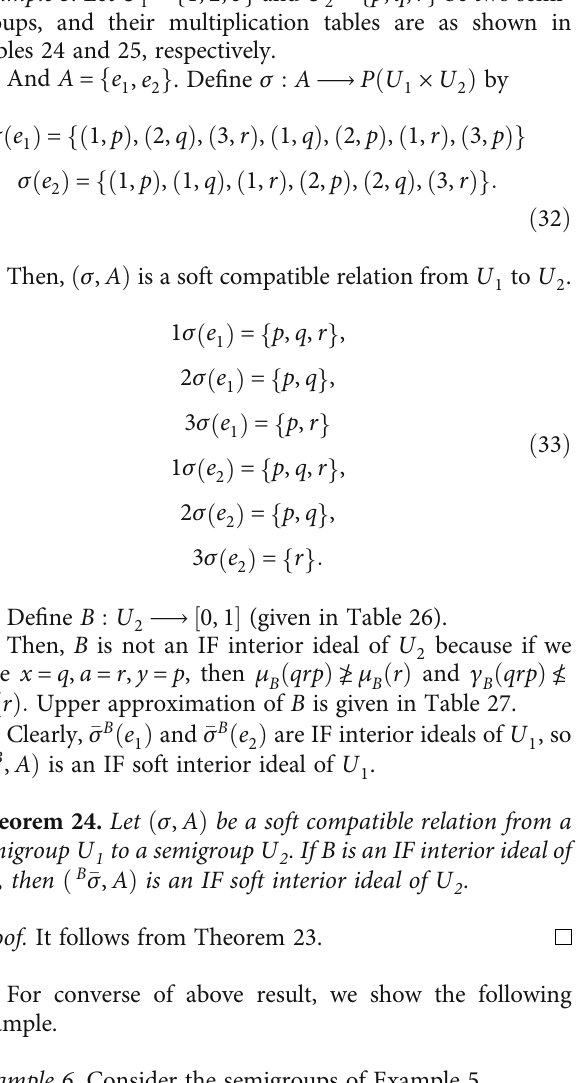
Table 24: Multiplication table for U